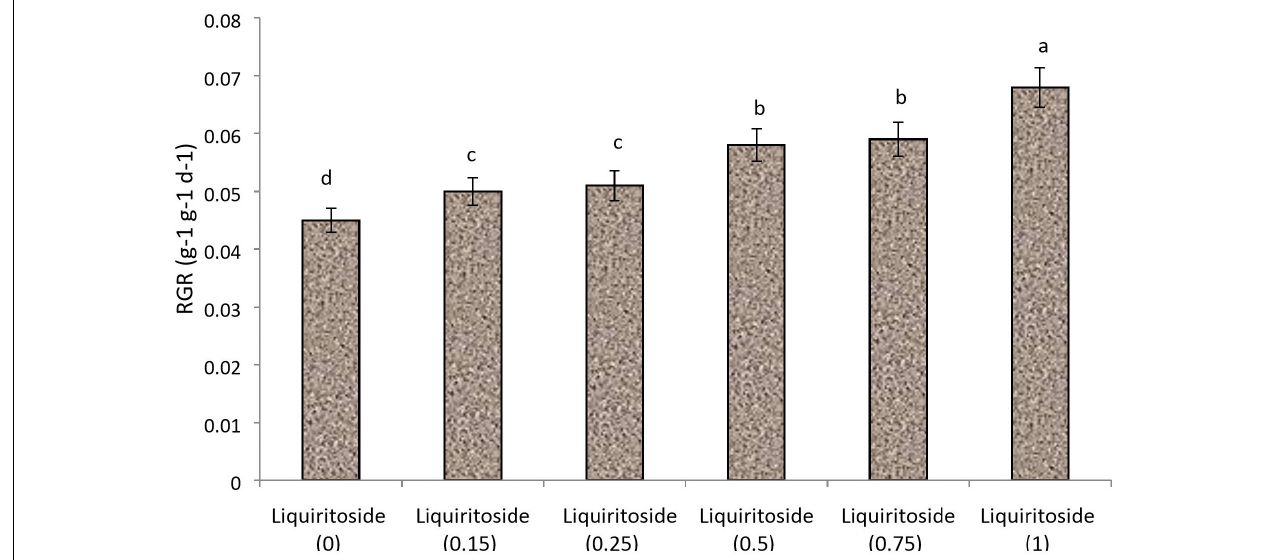
FIGURE 1 | Effect of various doses of liquiritoside (g/L) on the relative growth rate (RGR) of Chinese flowering cabbage. Mean values of two independent experiments are presented. Vertical bars show standard error between different replicates of the same treatment. Data marked by different letters are significantly different at p <